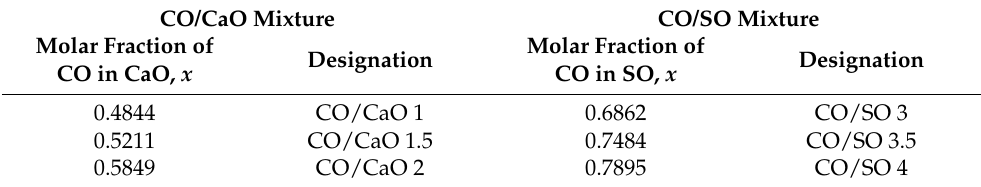
Table 5. The molar concentration of binary oil mixtures next to the transition